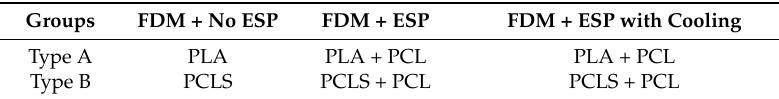
Figure 1. Schematic of hybrid processing with Fused Deposition Modeling (FDM) and electrospinning (ESP) with cooling system: ( a ) initial fused deposition modeling stage; ( b ) subsequent electrospinning stage; and ( c ) subsequent fused deposition modeling stage. The cooling control system was configured as open-loop system with an on/off controller. A constant temperature of 10 °C was setting as set point. Table 2. Materials and cooling conditions.